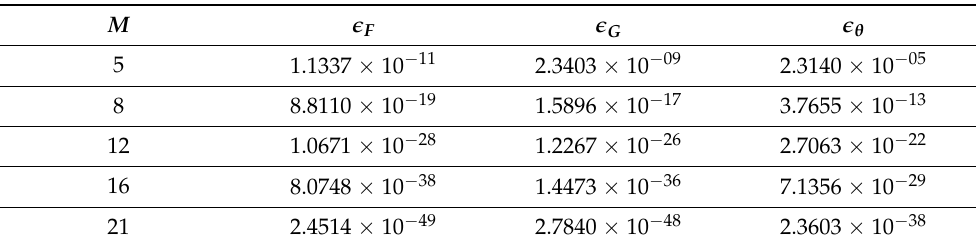
Table 2. Analysis of the square residual error of least square methods with various degree of approximation.